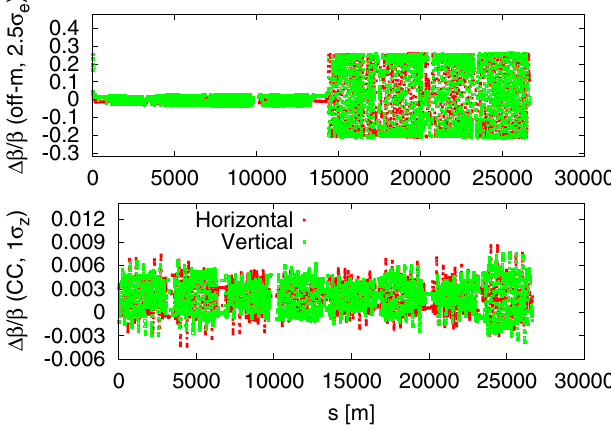
FIG. 12. (Color) Off-momentum beta beating for the lowbeta- max collision optics with a relative momentum offset of 0.000 27 (top); z -dependent beta beating due to the global crab cavity (bottom), which is much smaller than the off-momentum beta beating.